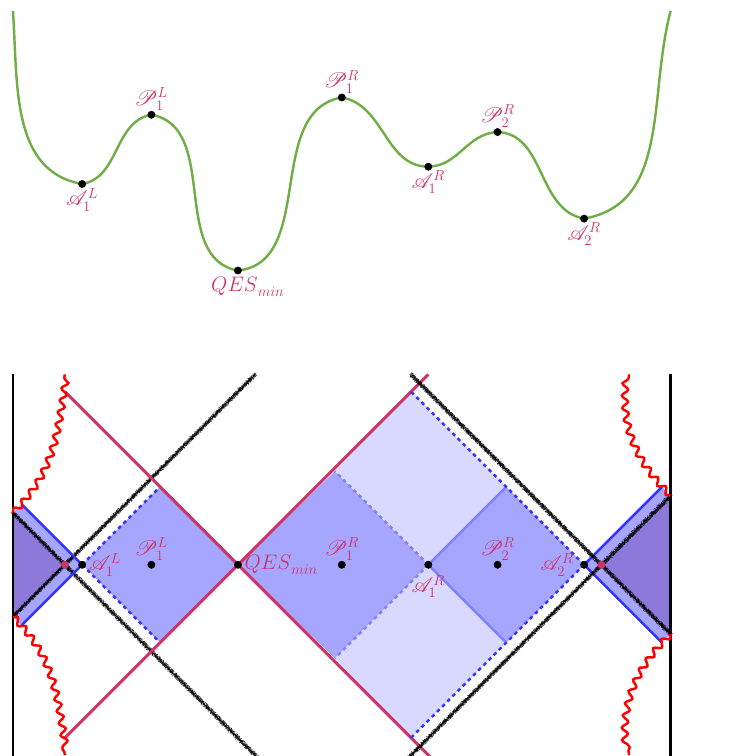
Figure 6 . A dilaton field with python’s lunch geometries and the corresponding Penrose diagram. to A R . Accordingly, the degrees of freedom associated with P R 1 wedge of the new QES . In this case, those degrees would no longer be reconstructed min from the right boundary according to the entanglement wedge hypothesis. Instead, it would be reconstructed from the left